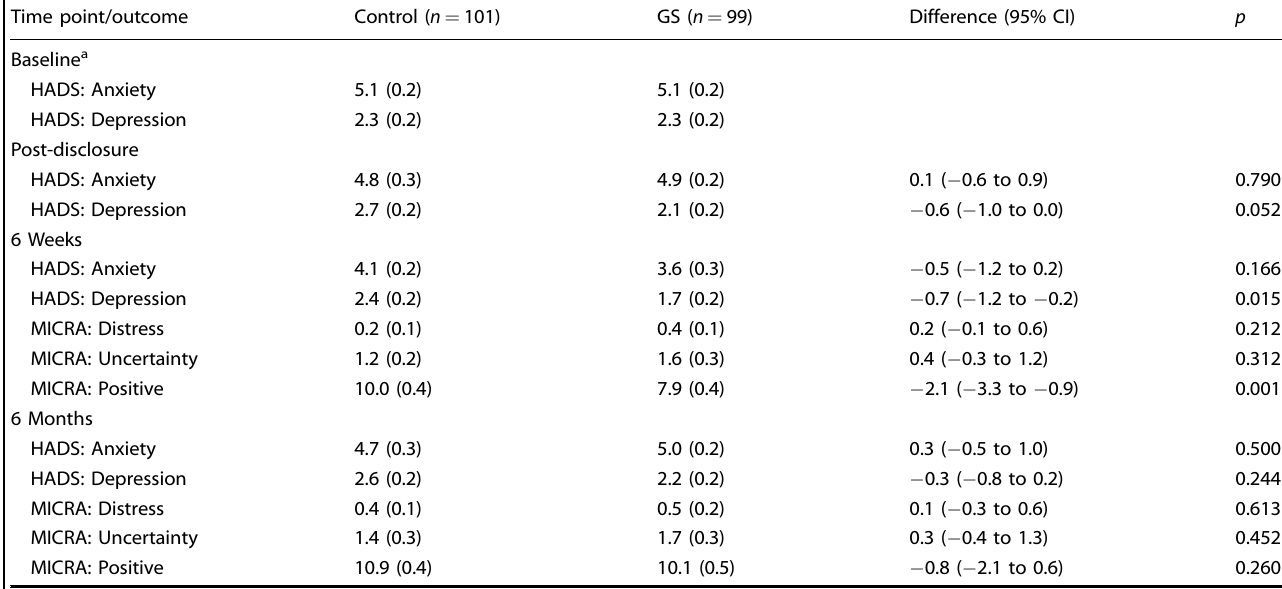
Table 4. Psychological outcomes on continuous measures.